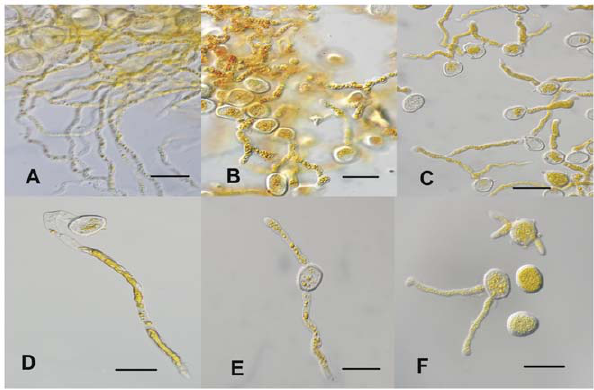
Figure 2. Immuno-suppressive drugs assay of Pst urediospores. Pst race CYR31 was treated with water (A, D), CsA (0.1 m M, B, E), or FK506 (1 m M, C, F). Treatment with either drug can limit the elongation of Pst germ tubes and block further differentiation. Analyses were performed using the light microscope; scale bar, 50 m m.